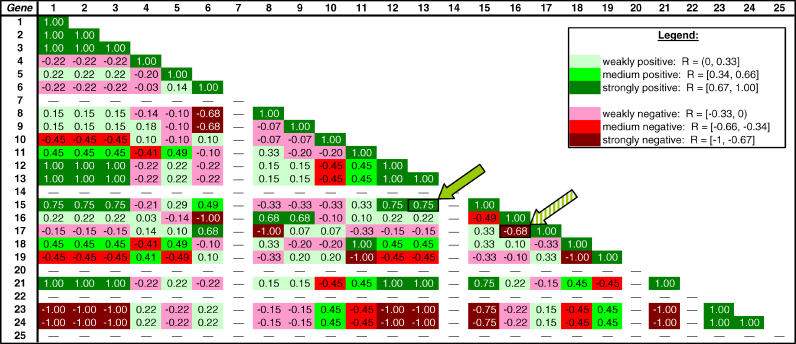
The Correlation between Gene Expression across All the Environments for the Prototypic TRSColors indicate that the expression of two genes is correlated (green if the expression of one gene is correlated with the expression of another, red if the expression of one gene is correlated with the lack of expression of another), and the darker the color the stronger the correlation. For example, the expression of Gene 13 is strongly correlated with that of Gene 15 (0.75) (as indicated by the solid arrow), whereas the expression of Gene 17 is strongly correlated with the lack of expression of Gene 16 (and vice versa) (−0.68) (as indicated by the striped arrow). This representation identifies genes that function together versus those that function independently, and, consequently, genes that are part of the same regulated units can be identified. These correlated gene sets can therefore guide experimental design.